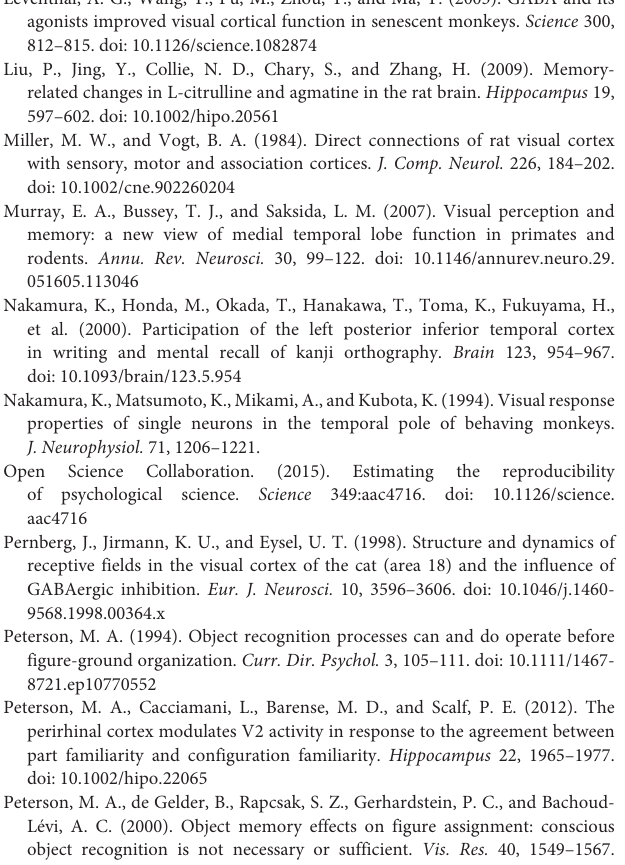
figure-ground organization. Curr. Dir. Psychol. 3, 105–111. doi: 10.1111/1467-